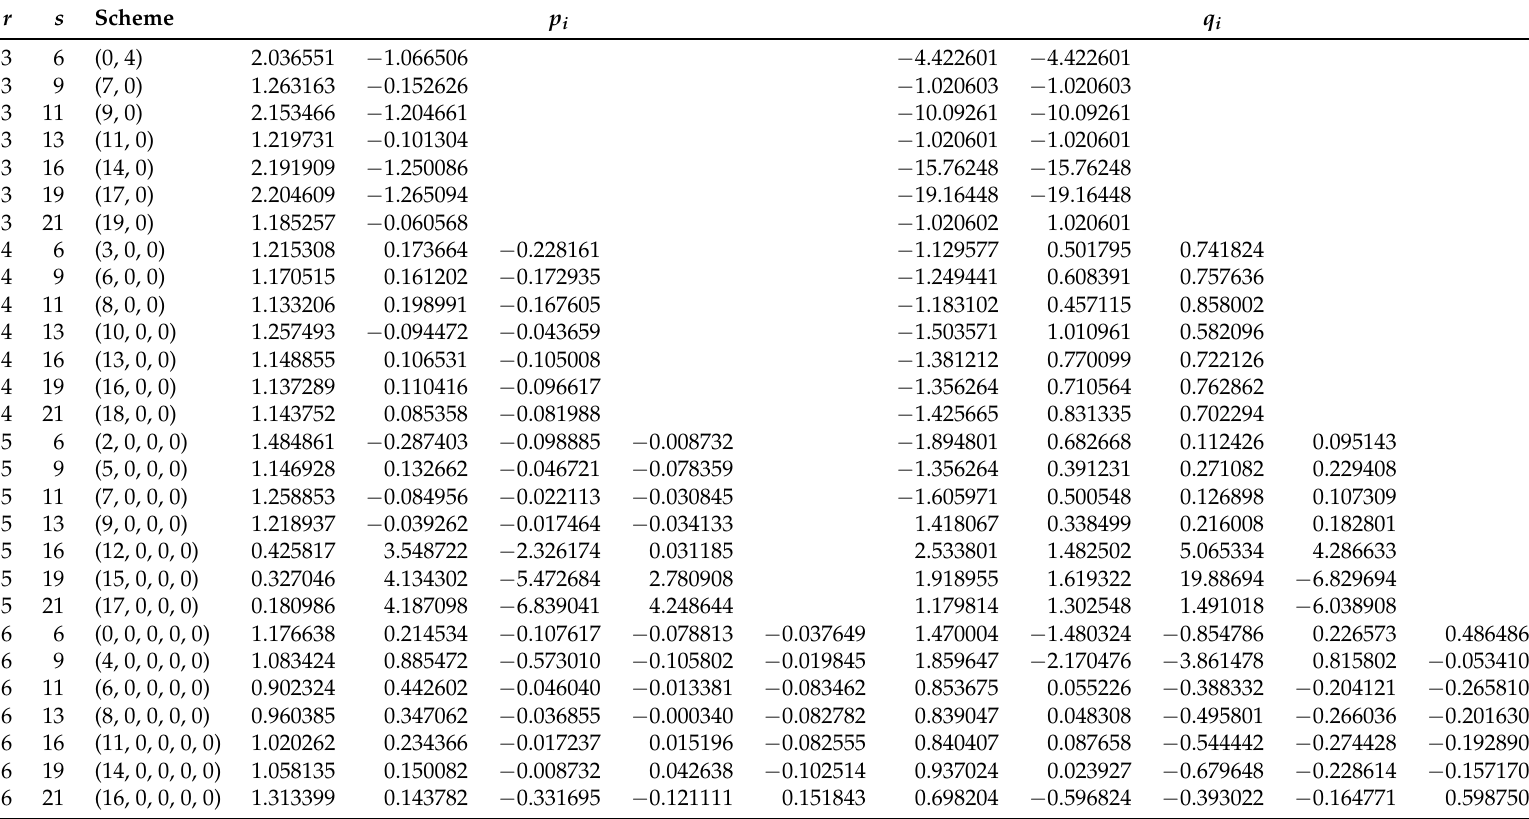
Table 5. Coefficients of the BLUEs for some selected progressive censoring schemes of µ and σ for λ =